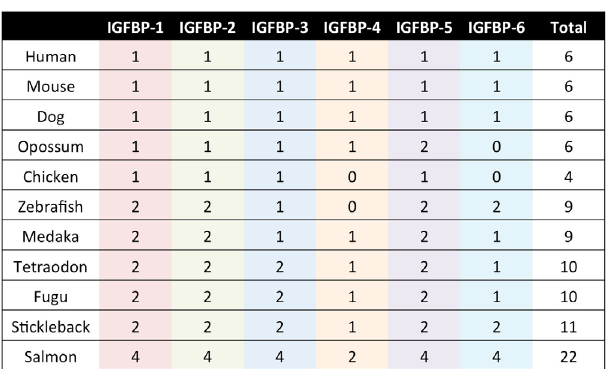
TABle 1 | The IGFBP gene repertoire in selected vertebrate